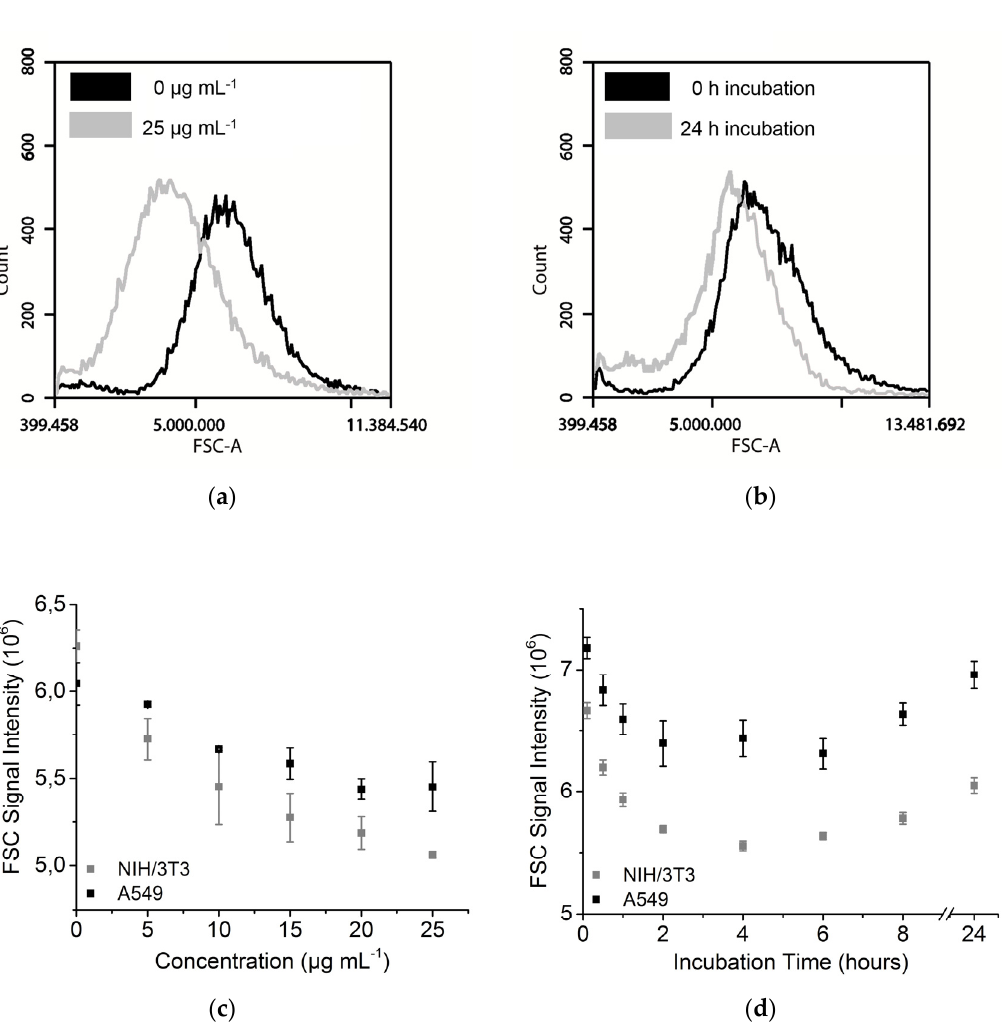
Figure 4. Forward scattering signal of A549 and NIH/3T3 cells. ( a ) Histogram of FSC signal with 0 μ g mL − 1 and 25 μ g mL − 1 FITC ‐ TiO 2 and 24 h incubation (NIH/3T3); ( b ) Histogram of FSC signal after 0 h and 24 h incubation of 12.5 μ g mL − 1 FITC ‐ TiO 2 (NIH/3T3); ( c ) Forward scatter after incubation with different FITC ‐ TiO 2 NPs concentrations (24 h incubation); ( d ) Uptake kinetic of FITC ‐ TiO 2 NPs (12.5 μ g mL − 1 ).